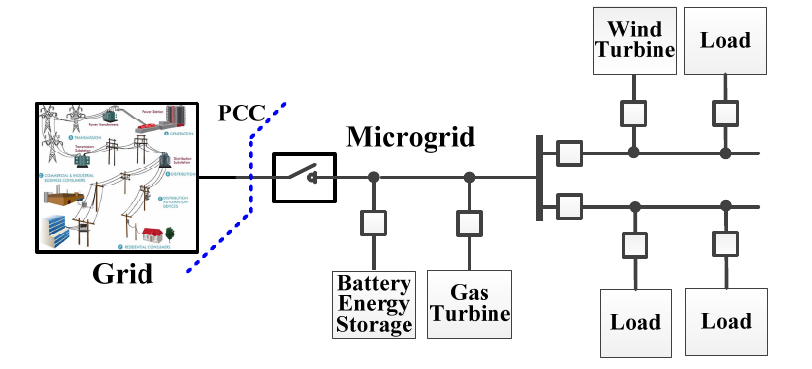
Figure 1. Configuration of overall microgrid control network.